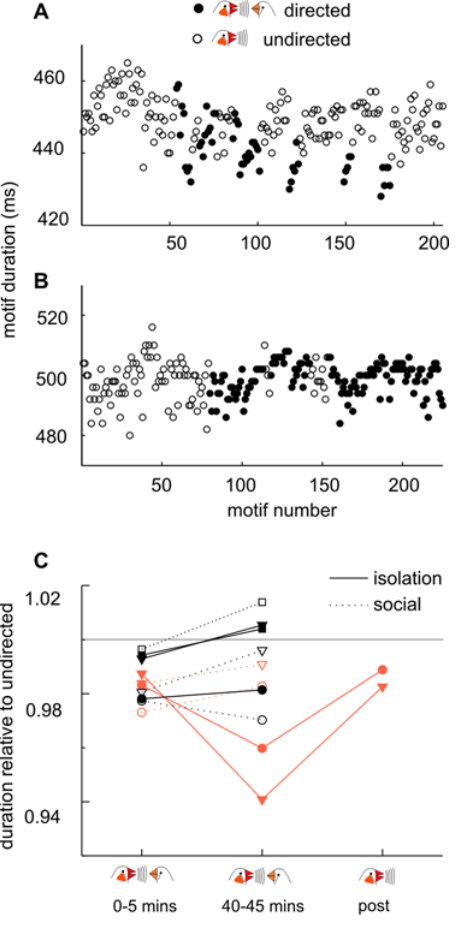
Figure 5. Several days of social isolation can prime short-term song plasticity. (A,B) Duration of successive song motifs produced while alone (empty circles, undirected singing) and targeted to female birds (filled circles, directed). Experiments plotted in A and B represent examples of high (A) and low (B) levels of short-term alteration of song structure during exposure to females. (C). Summary of results from 5 birds recorded while singing to females after 5 days of social isolation (filled symbols, solid lines) or 5 days of daily exposure to females (open symbols, dotted lines). Each point is the plotted the ratio of motif duration relative to undirected song motifs recorded in 10 minutes prior to female presentation, during the three epochs 0–5 minutes after presentation, 40–45 minutes after presentation, and during undirected singing after females were removed. Data from two birds whose directed song motifs were clearly shortened from early to late during female exposure, only after isolation, are displayed in orange. Isolation and social conditions for each bird are plotted with identical symbols and colors.